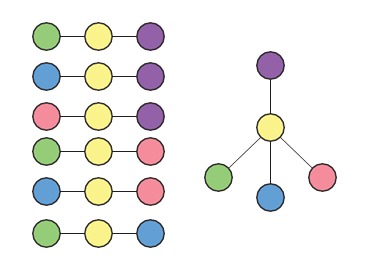
DOI:
http://dx.doi.org/10.7554/eLife.20487.022